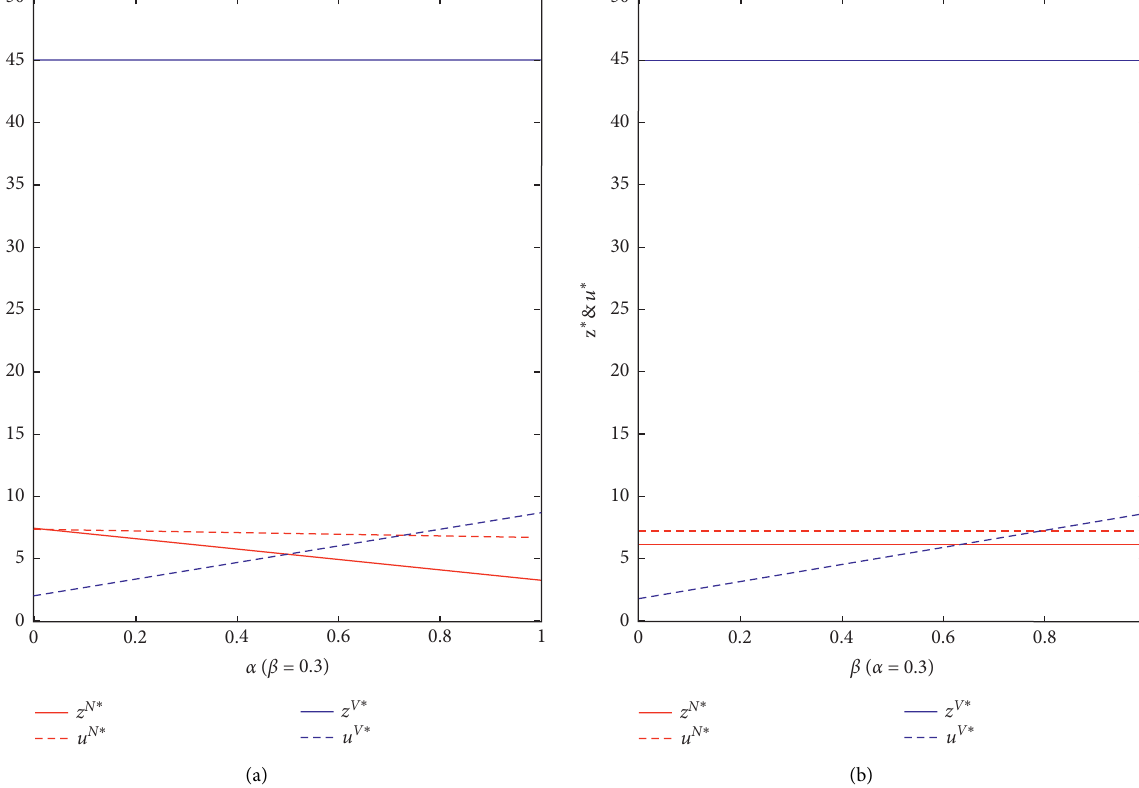
Figure 5: (a) The impact of cooperation models and technology spillovers α on optimal innovation decisions. (b) The impact of cooperation models and technology spillovers β on optimal innovation decisions.